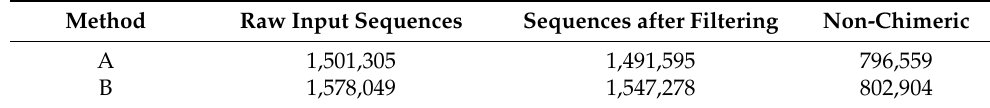
Table 2. Sequencing results for each DNA extraction method 1